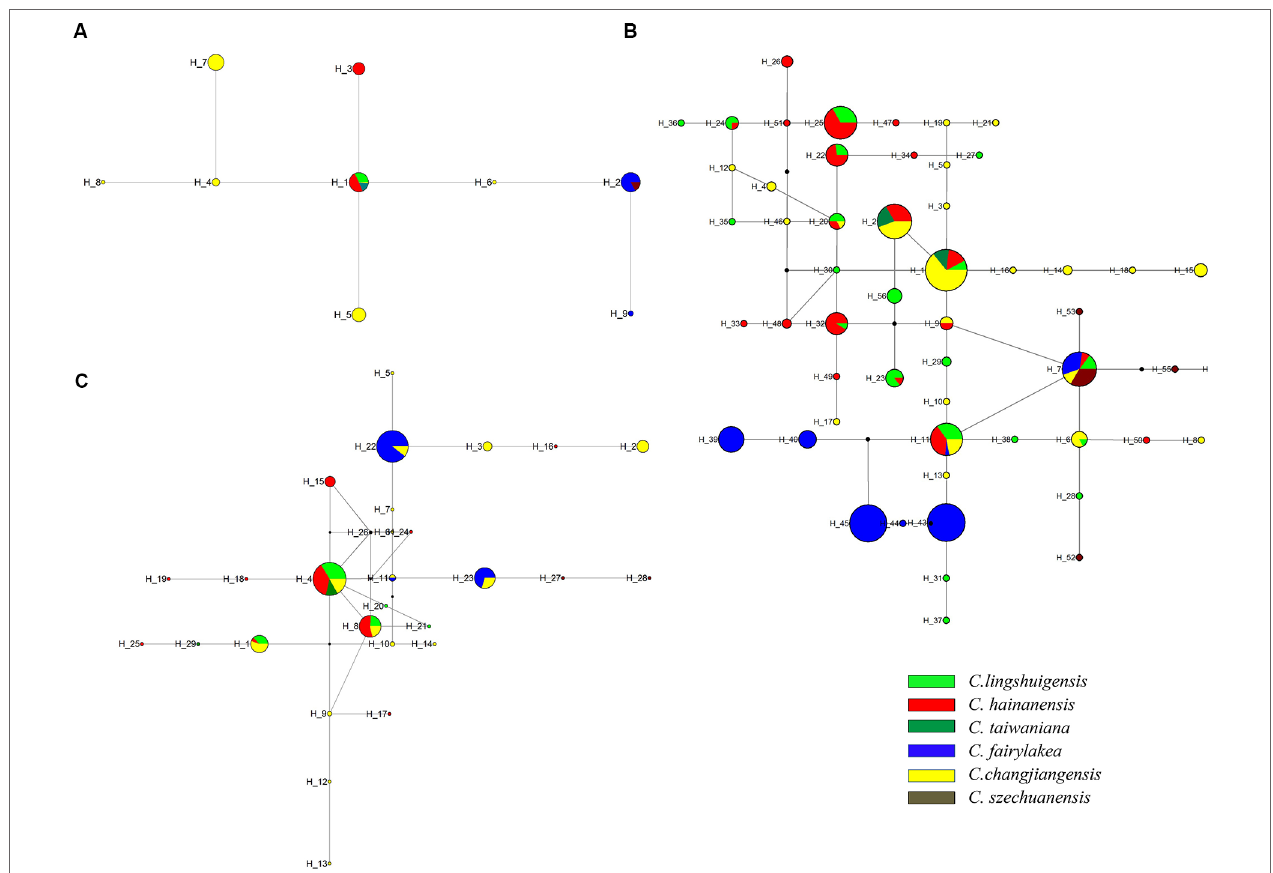
FIgUrE 2 | Haplotype network of the Cycas taiwaniana complex based on chloroplast DNA (cpDNA) (A) , EX (B) , and FJ (C) . The small black dots represent missing intermediate haplotypes. Each indicates one haplotype. The diameter of the circle is proportional to the number of samples. Each of the six species of the C. taiwaniana complex is represented by a different color .